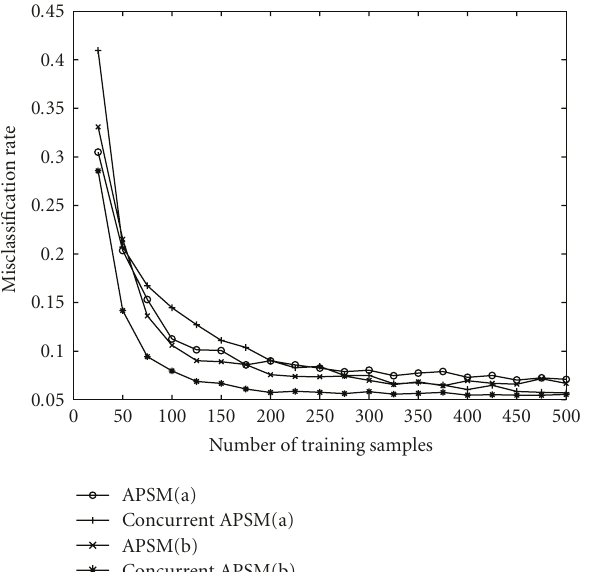
Figure 6: Here, the LTI system is again H 1 , with card( J n ) : = 8, for all n . The variance of the Gaussian kernel takes the value of σ 2 : = 0 . 2. The bu ff er length L b : = 500, and α : = 0 . 5. The extrapolation coe ffi cient is ’ μ n : = 1 . 9 * M n , for all n .